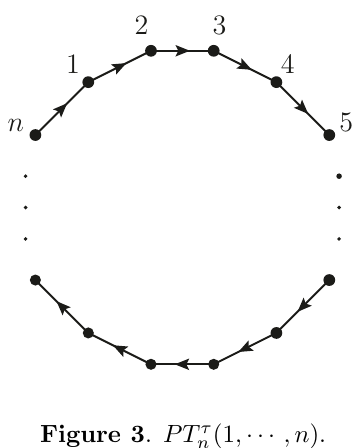
Figure 3 . PT (cid:28)